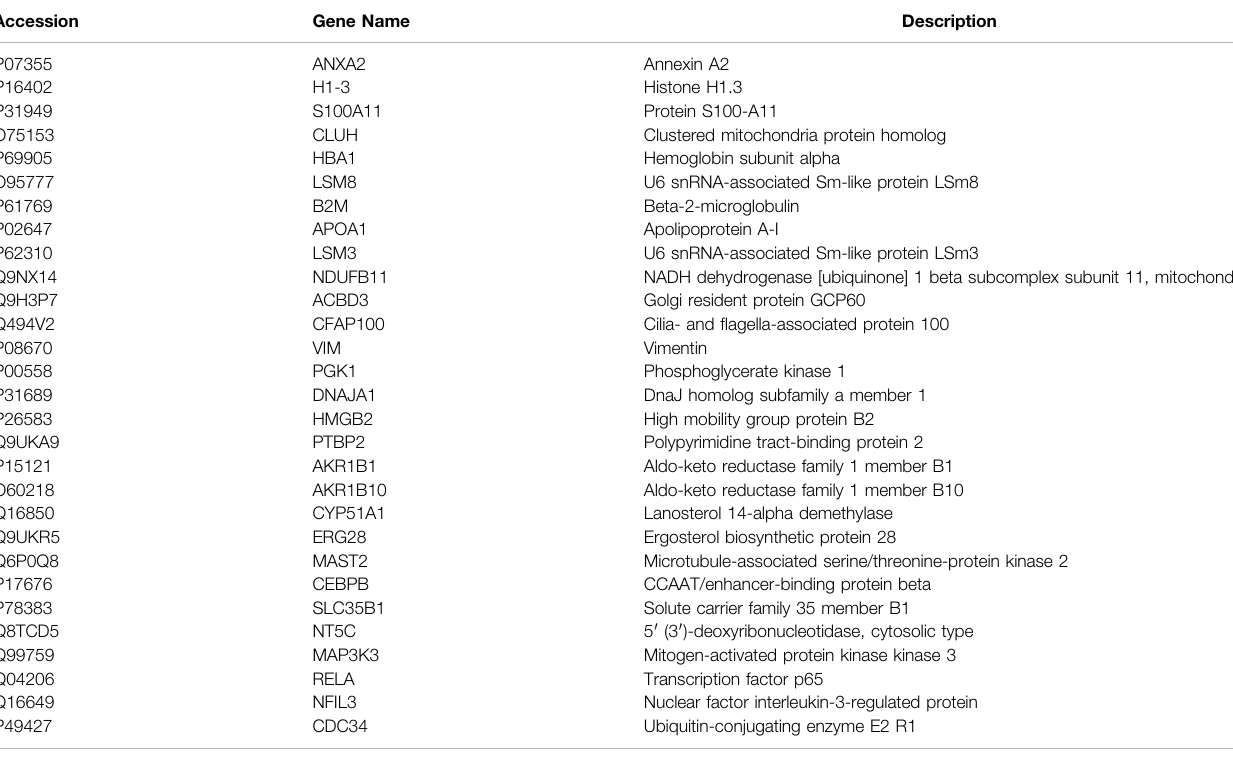
TABLE 1 | The common differentially expressed proteins.